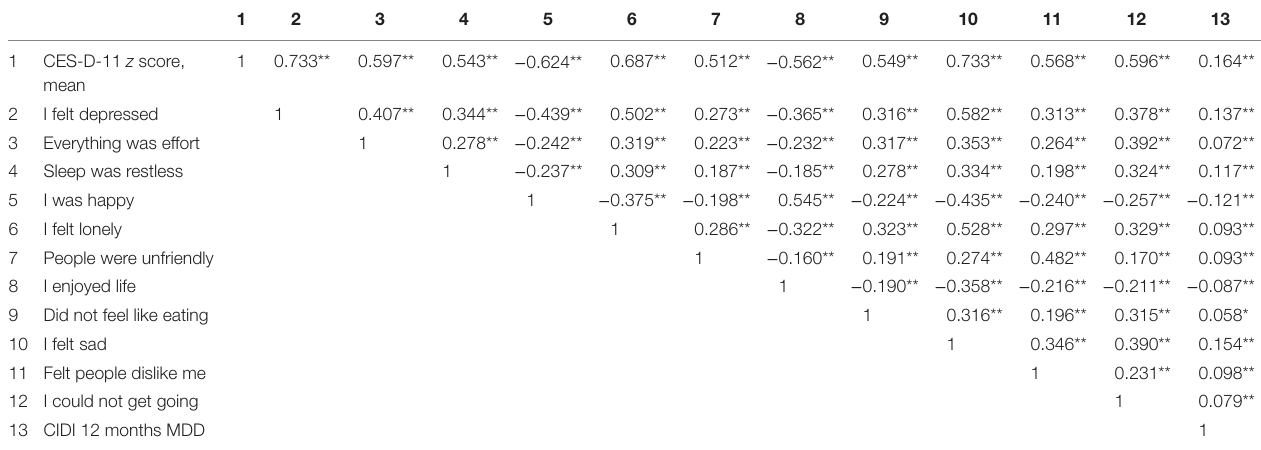
TaBle 3 | correlations between baseline ces-D score, ces-D items, and ciDi-based depression after 15 years in the pooled